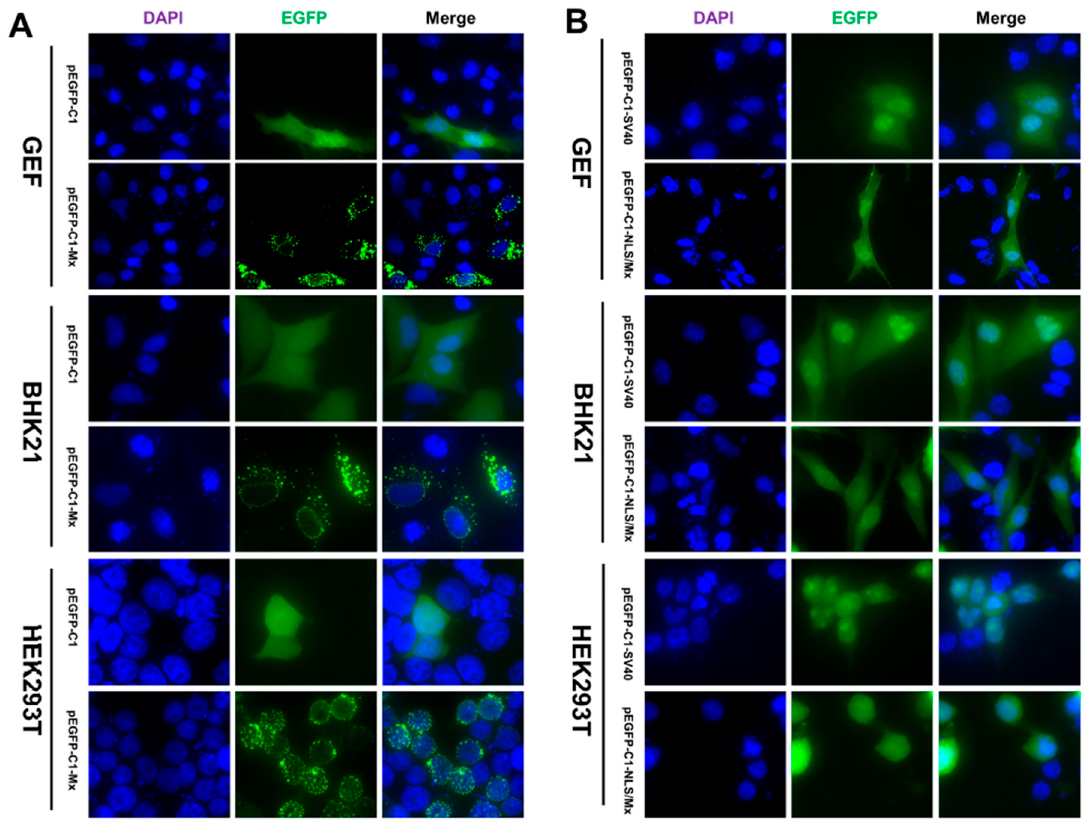
Figure 3. Cellular localization of the goMx protein. ( A ) Subcellular localization of pEGFP-C1-Mx in GEF, baby hamster kidney (BHK21), and human fetal kidney (HEK) 293T cells. Cells were transfected with indicated plasmids (pEGFP-C1-Mx or pEGFP-C1). At 24 h post-transfection (hpt), cells were fixed and stained with 4 (cid:48) ,6-diamidine-2 (cid:48) -phenylindole dihydrochloride (DAPI). ( B ) The putative bipartite nuclear localization signal (NLS) is attributed to the nucleus localization of the fusion goMx protein. Localizations of pEGFP-C1-NLS/Mx in GEF, BHK21, and HEK 293T cells are shown, while pEGFP-C1-SV40 works as the positive control. The overexpressing protein appeared green, and the nucleus was stained blue with DAPI. Fluorescence was observed by fluorescence microscopy under a magnification of 400 times and analysed using Image Pro Plus